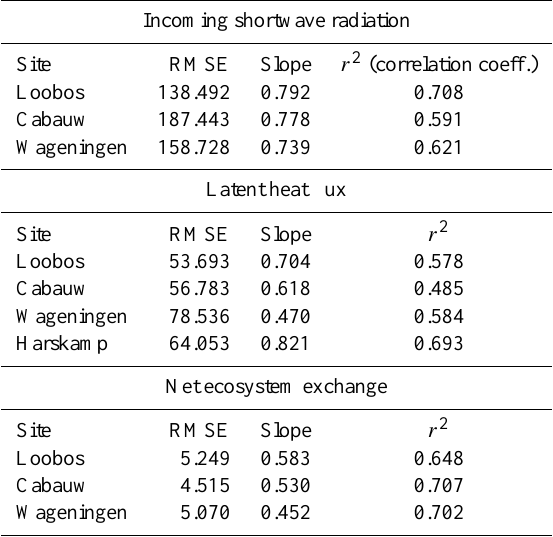
Table 4. Statistical analysis of simulated against observed short- wave incoming radiation (Wm − 2 ), latent heat flux (Wm − 2 ) and net ecosystem exchange (µmolm − 2 s − 1 ). based on hourly observations and simulated results for the